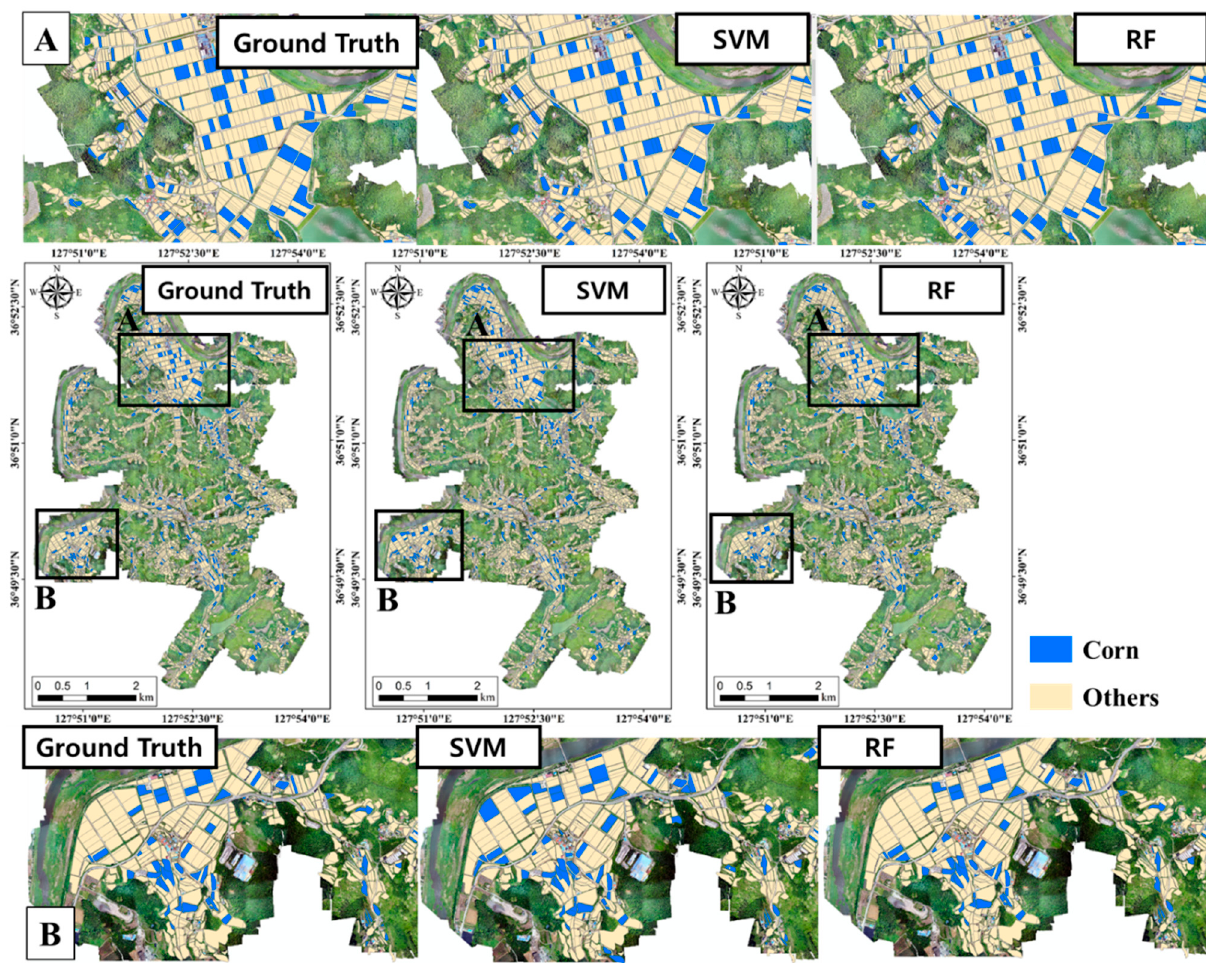
Figure 12. Analysis result of corn plantations classified using the field survey and Farm Map-based SVM and RF algo- rithms. Table 5. Error matrix for evaluating the accuracy of the Farm Map-based SVM algorithm.